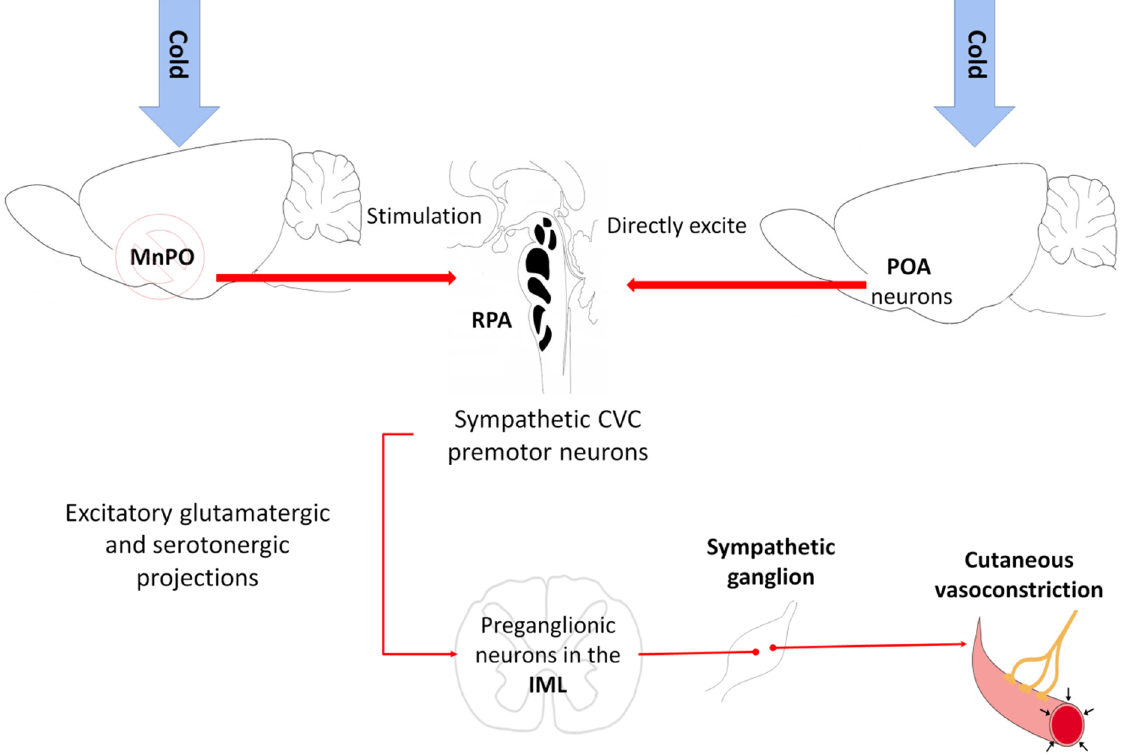
Figure 7. Neurophysical mechanism for developing the cutaneous vasoconstriction response. Perceptions of cold in the brain cause inhibition of the median preoptic nucleus (MnPO), which stimulates the sympathetic cutaneous vasoconstrictor (CVC) premotor neurons in the raphe pallidus area (RPA). These neurons send excitatory glutamatergic and serotoninergic projections to the preganglionic neurons in the intermediolateral cell column (IML) of the spinal cord that, when activated, generate peripheral vasoconstriction. Note that activating the preoptic area (POA) neurons by a cold stimulus can be excited directly through the sympathetic CVC premotor neurons.